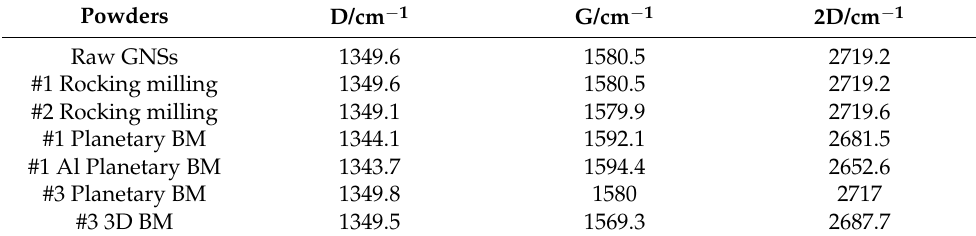
Table 1. GNS peak position obtained from Raman